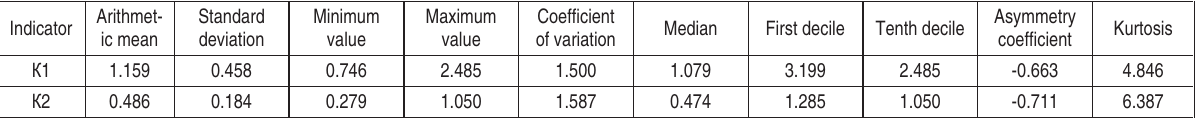
Table 2. Statistical analysis of indicators of the financial state of Ukraine’s economy branches Arithmet- Standard Indicator ic mean